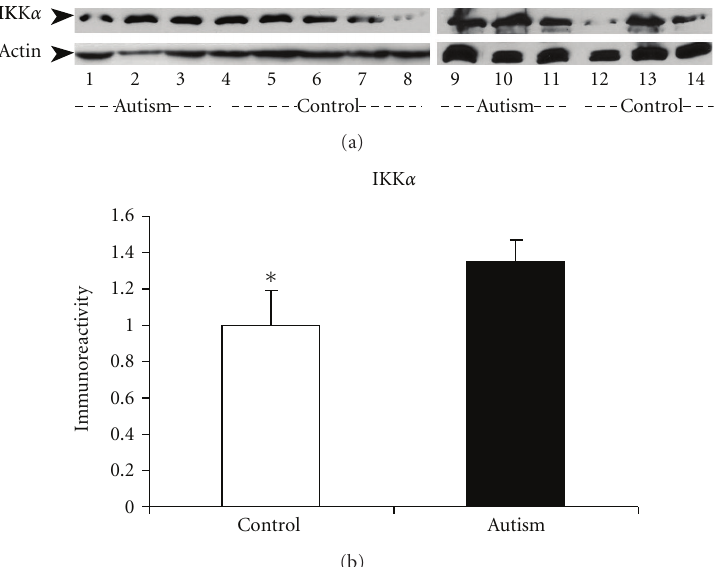
Figure 1: IKK α protein expression in the cerebellum of autistic subjects. (a) Two independent western blot studies on cerebellar homogenates using IKK α antibody (dilution 1:1000). Lanes 1–4 and 9–11 represent autistic subjects, and lanes 5–8 and 12–14 represent controls. The lower panel shows actin bands (MW: 48 kd), and the upper panel shows the IKK α bands (MW: 85kd). (b) The blots shown in (a) were quantitated after being normalized by actin. Data are shown as mean ± SE. ∗ P < 0 . 05 versus control group. White bars represent controls, and black bars represent autistic